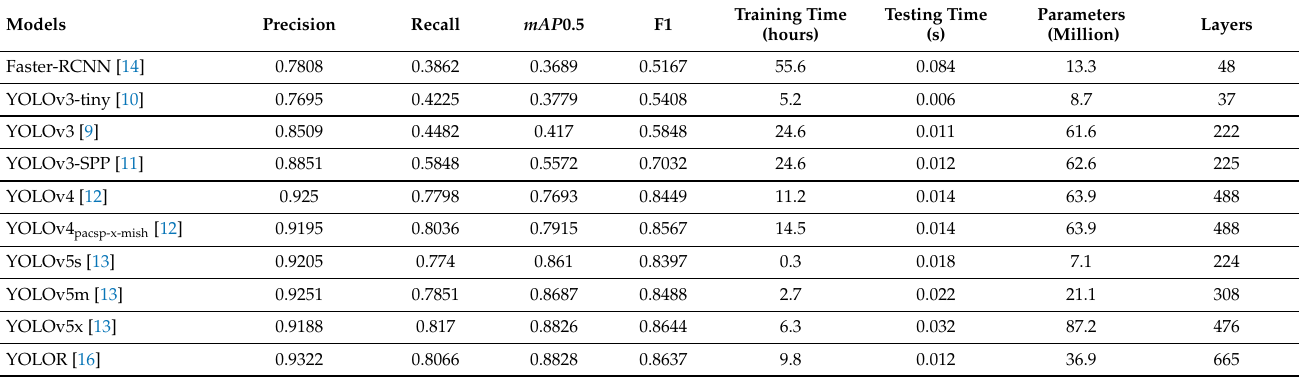
Table 8. Results of state-of-the-art models on the SHEL5K